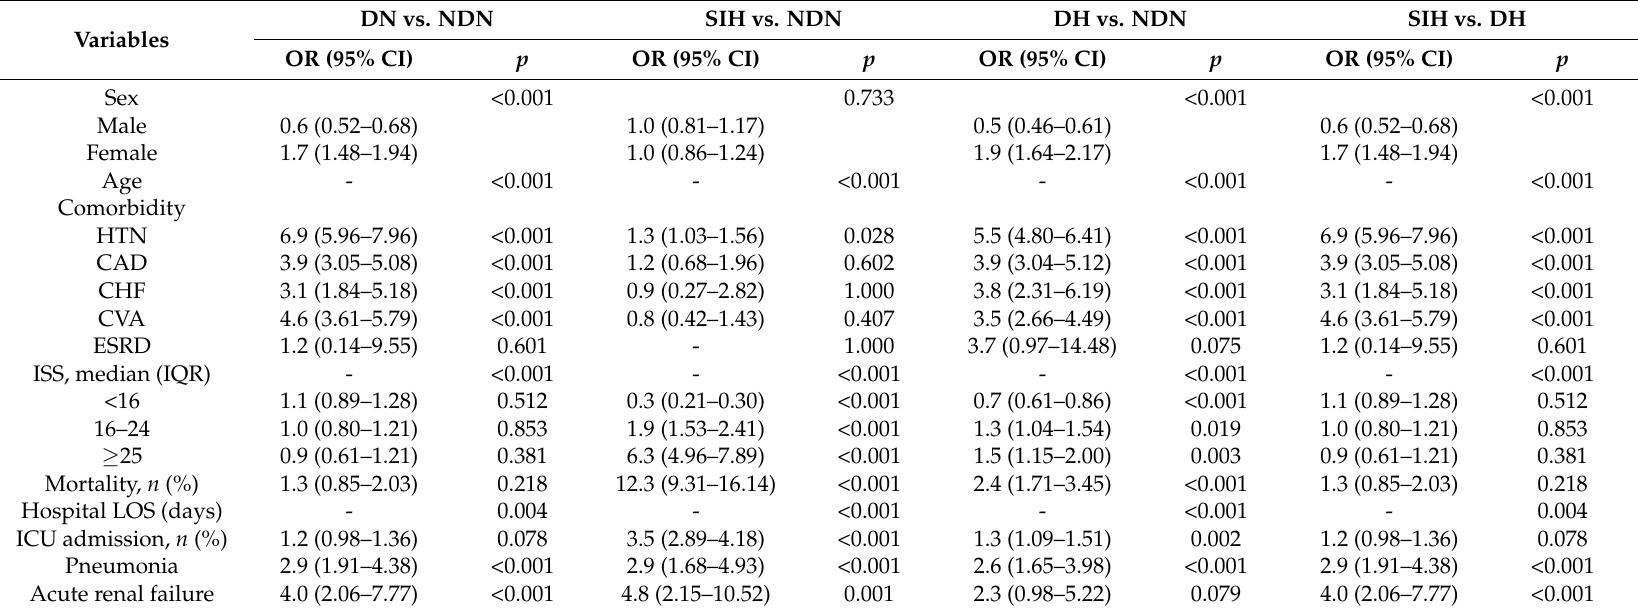
Table 2. Comparison of the characteristics, injury severities, and outcomes among the patient